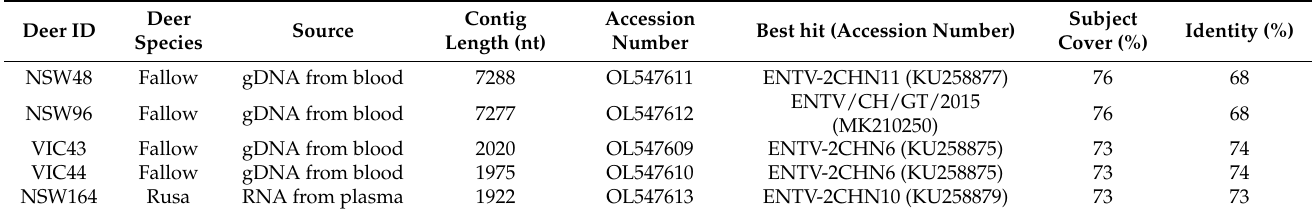
Table 1. Percentage identities of the assembled retroviral